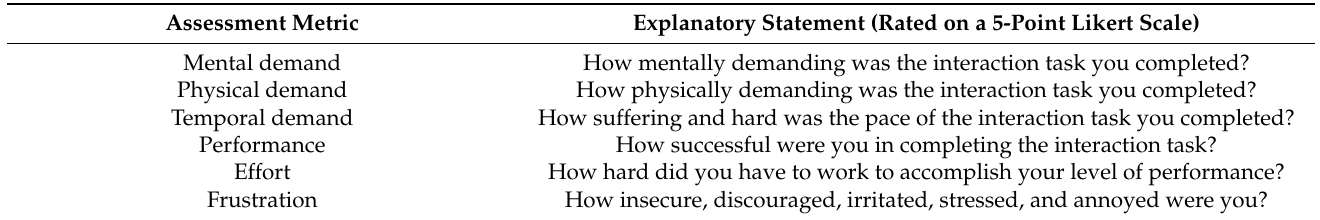
Table A1. Perceived arm-fatigue assessment questionnaire metrics and corresponding